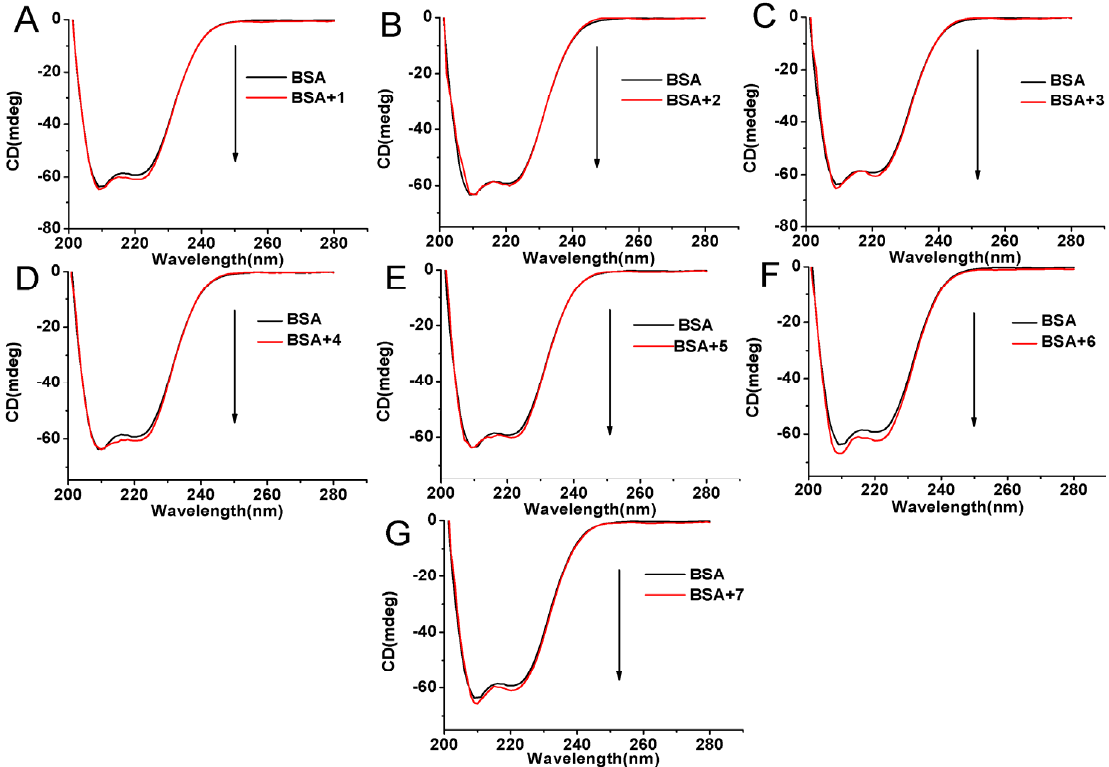
Figure 8. CD spectra of BSA (5 µ M) in the presence of compounds 1 ( A ), 2 ( B ), 3 ( C ), 4 ( D ), 5 ( E ), 6 ( F ) and 7 ( G ) in 0.05 mol L − 1 Tris-HCl, pH 7.4. The concentrations of the compounds were 30 μ M.